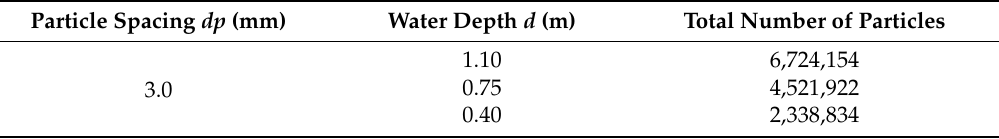
Table 4. Total number of particles for three water depths.